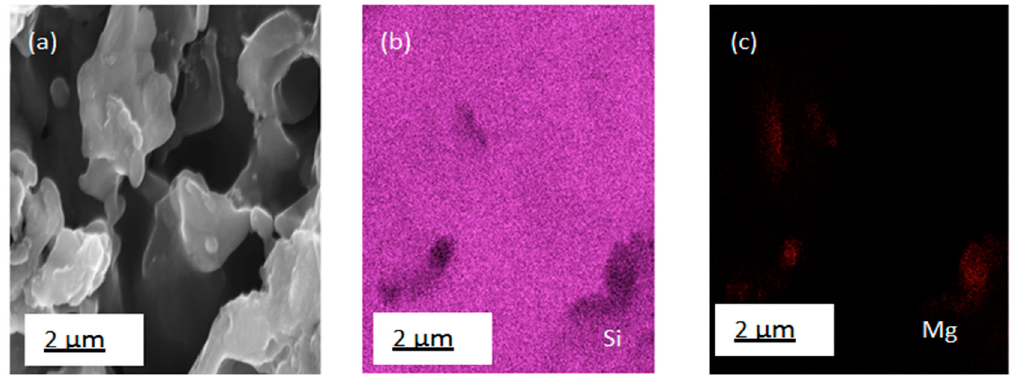
Figure 7. EDS elemental mapping of silicon nanoflakes after purification: etching with 1 M HCl, 5% HF and washing in deionized water. ( a ) SEM image of nanoflakes, ( b ) Si, and ( c ) Mg < 1% average.